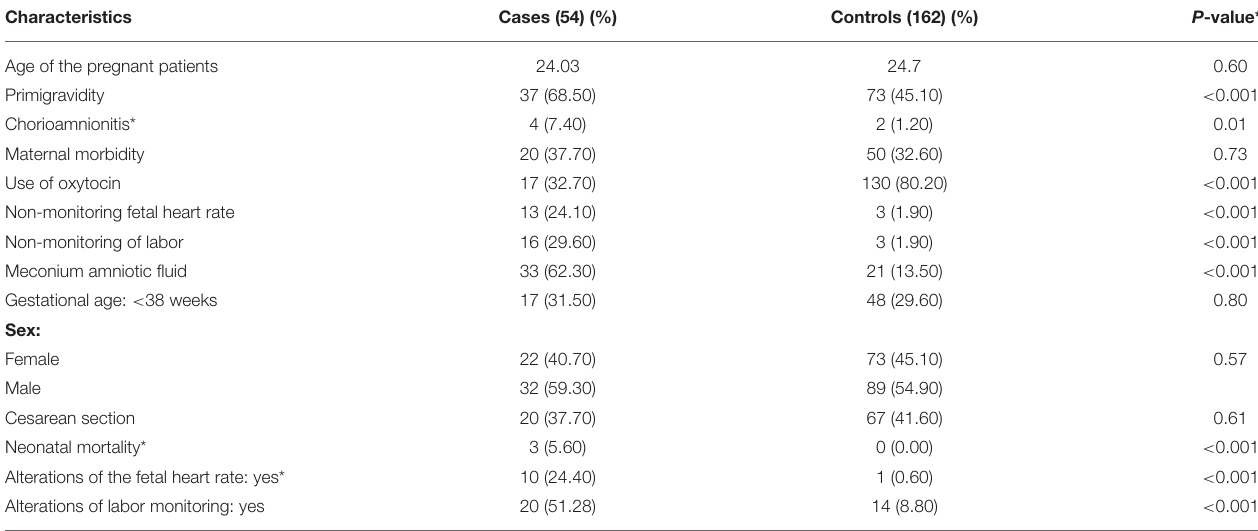
TABLE 1 | Description of biological variables.